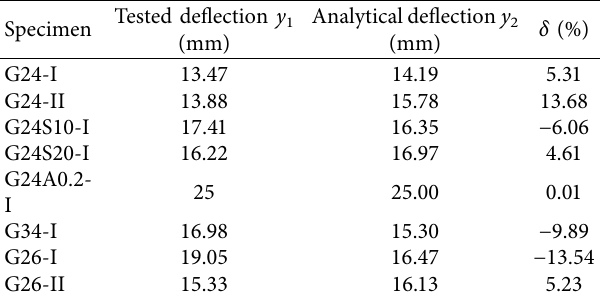
Table 8: Comparison of the maximum defection between ana- lytical and experimental